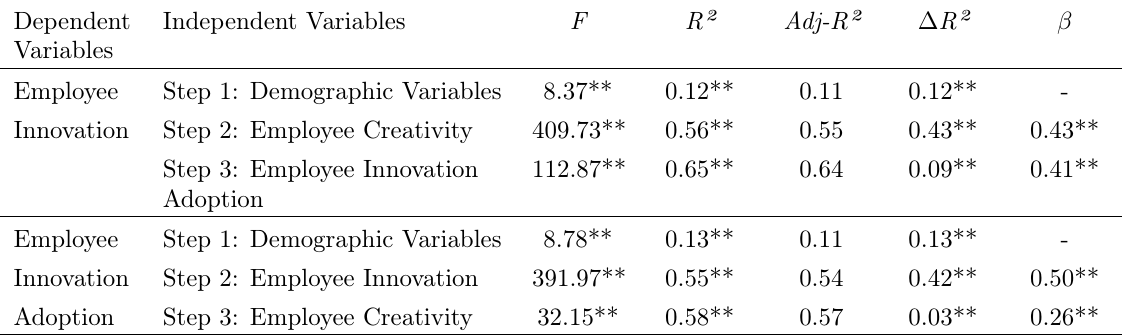
Table 2. Hierarchical Regression Analyses of the Causal Effects of Employee Creativity on Employee Innovation and Employee Innovation Adoption.